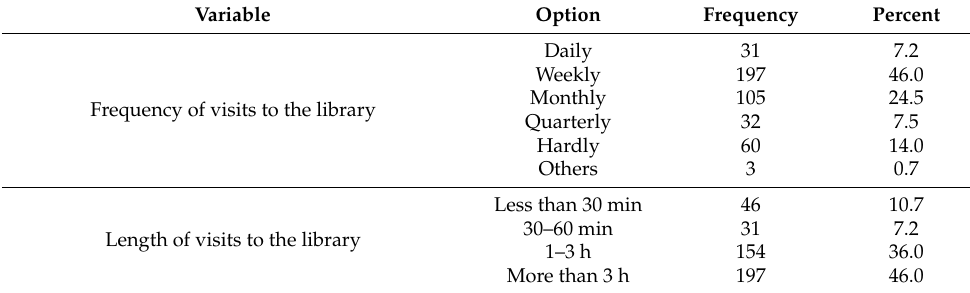
Table 8. Descriptive statistics of frequency and length of visits to the library.